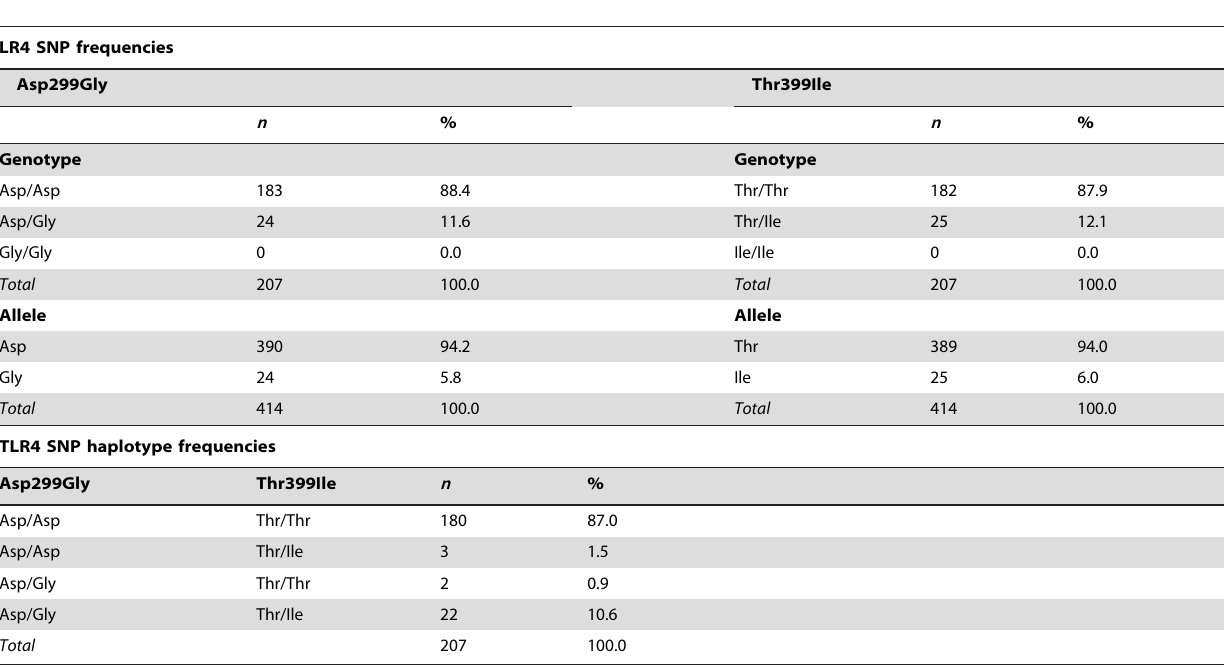
Table 1. TLR4 SNP genotypes, allele frequencies and